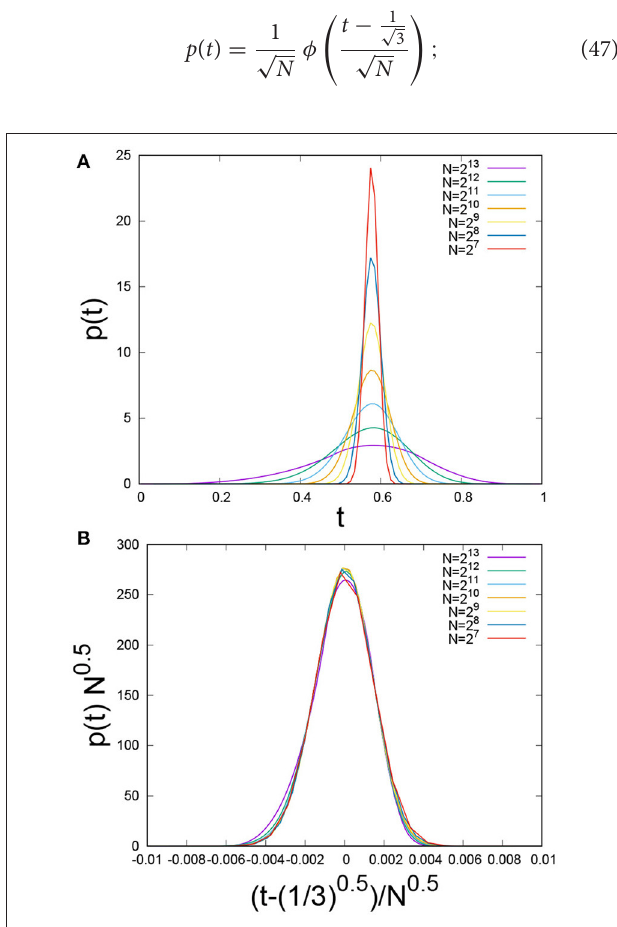
FIGURE 8 | Evolution of the force-load curve under the real space renormalization group. The starting point was 10 6 fiber bundles each 2 15 . containing N 2 15 fibers. The threshold distribution was uniform on the unit = = 1 ) is the initial force-load interval. The dotted curve 1 (1 −